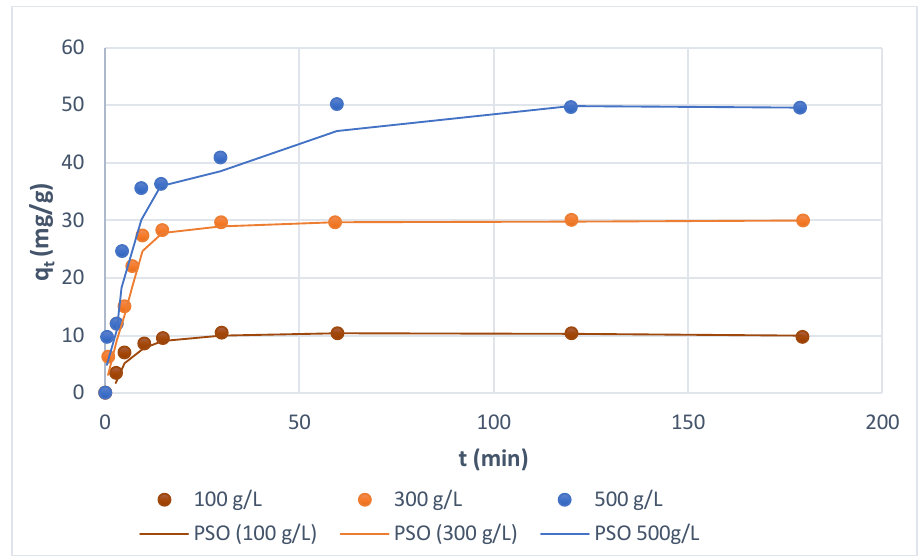
Figure 6. Effects of phase contact time and initial concentration of Direct Yellow RL on the amount of dye adsorbed by WBR.